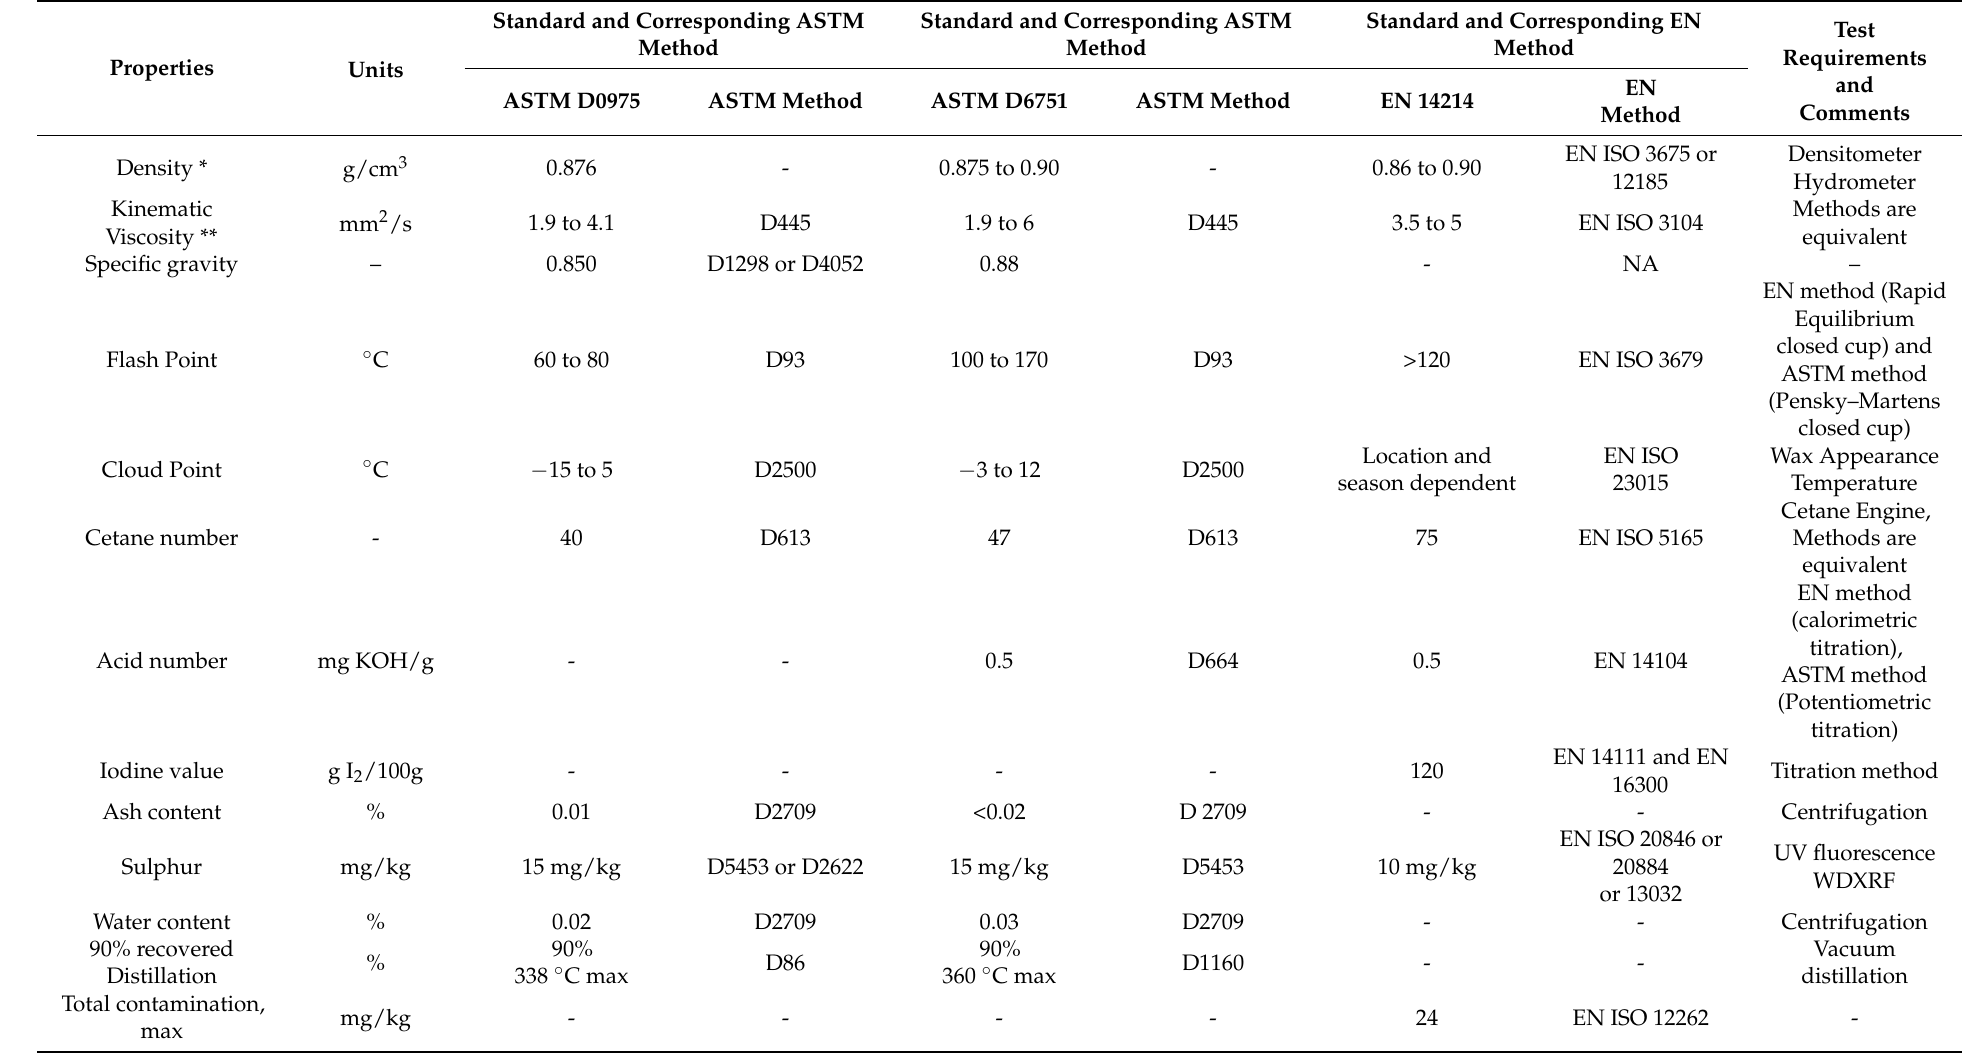
Table 5. Reference table for comparing synthesized biodiesel physicochemical characteristics with the international standards for biodiesel